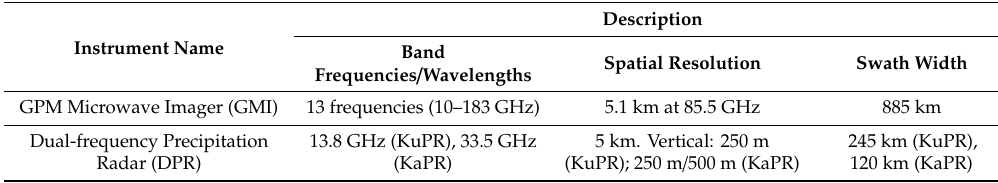
Table 2. Global Precipitation Measurement (GPM)